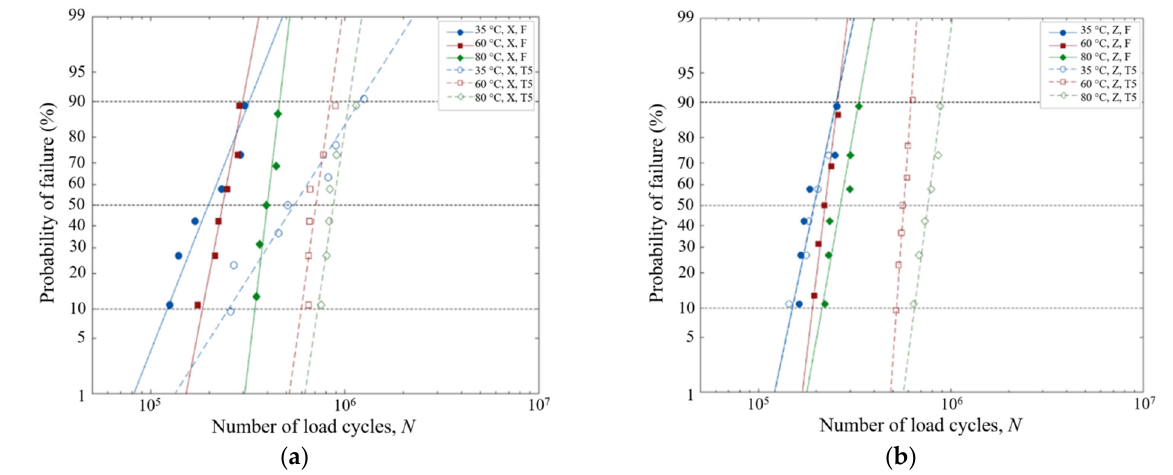
Figure 12. Probability of failure (%) vs. number of load cycles, N . The probability density function of log-normal distributions is fitted to each series of experimental results. The stress amplitude was 135 MPa for the 35 °C, 60 °C and 80 °C, X ( a ) and Z ( b ) building conditions.